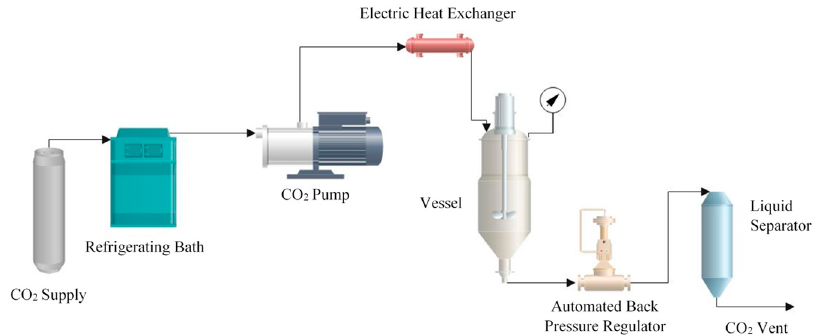
Figure 1. Diagram of the SSI pilot plant used for the experiments.